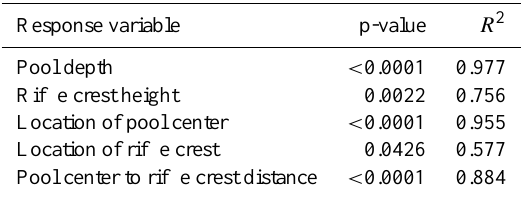
Table 2. Analysis of variance results for obstruction shape versus the five response